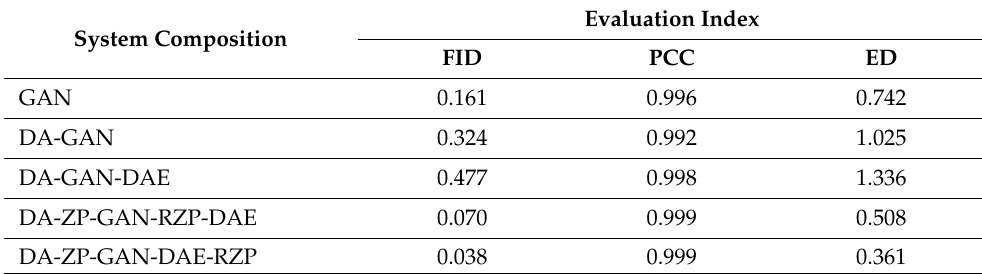
Table 7. Ablation study of the proposed system in terms of the evaluation